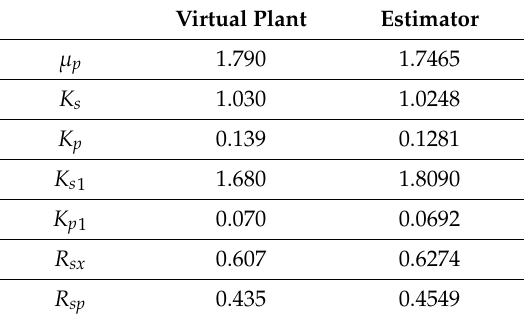
Table 1. Parameters for the virtual plant and for the estimator.